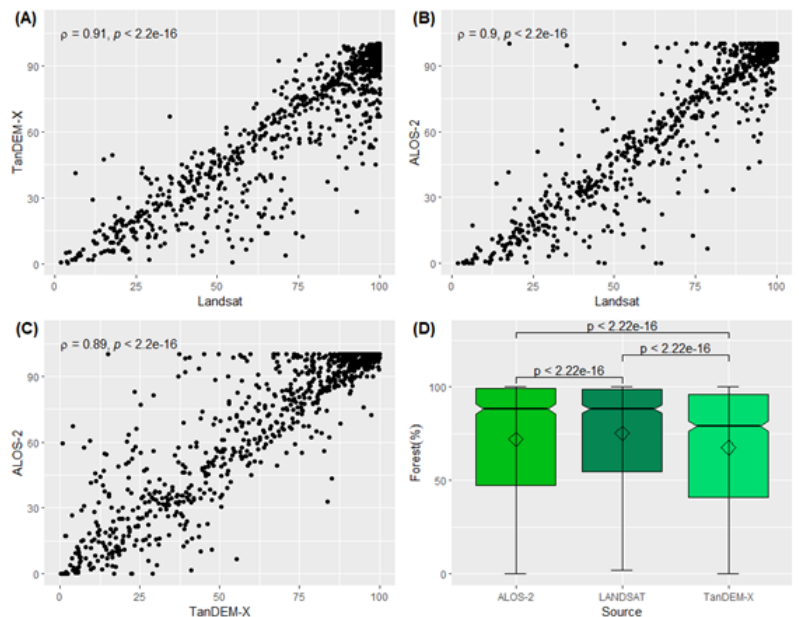
Figure 7. Relationship between the percentages of forest estimations obtained by the TanDEM-X, ALOS-2, and Landsat 8 OLI image interpretation ( A – C ) and the results of the Wilcoxon test ( D ) over the Amazon biome at the local level (image samples).